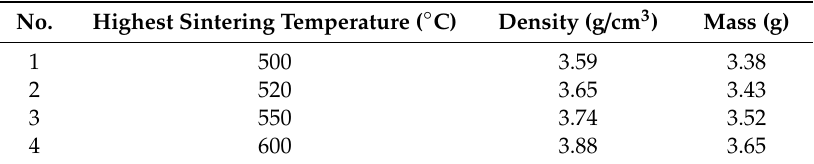
Table 1. Parameters of the Fe / Al